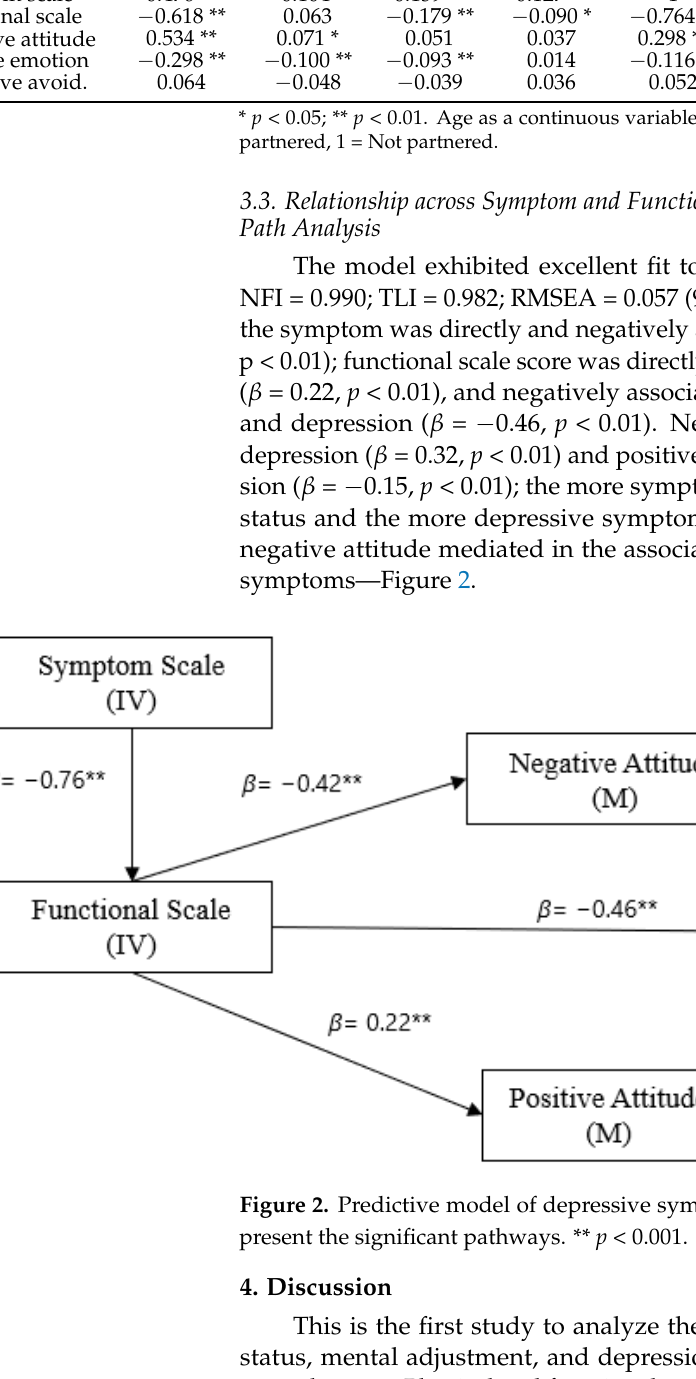
Table 2. Correlations across depressive symptoms and study variables.